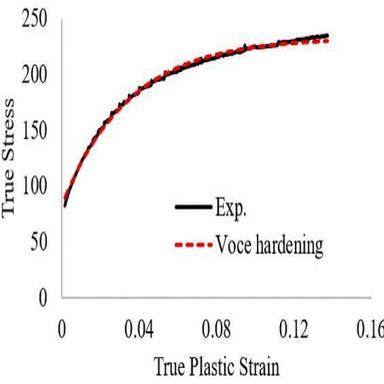
Voce hardening model fitted to the true stress-plastic strain curve obtained from the uniaxial tension test on the extruded AA7075-O tube.